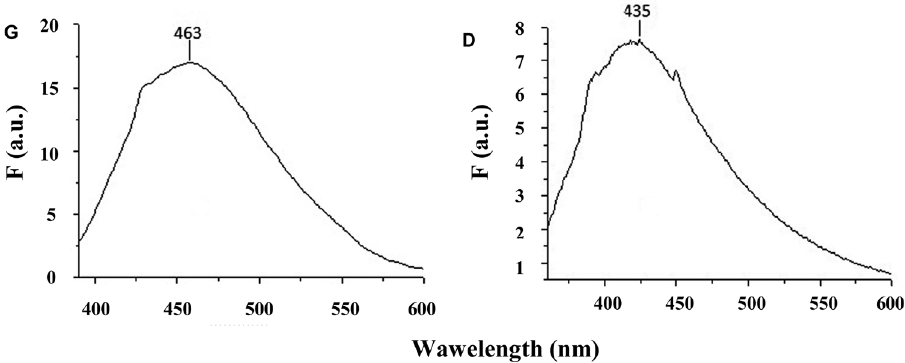
Figure 8. FP spectra of the samples of ethanol extracts of M . graniger graniger ( G ) and M . graniger dragani ( D ) samples ( λ ex = 380 nm) (F (a.u.) = fluorescence arbitrary